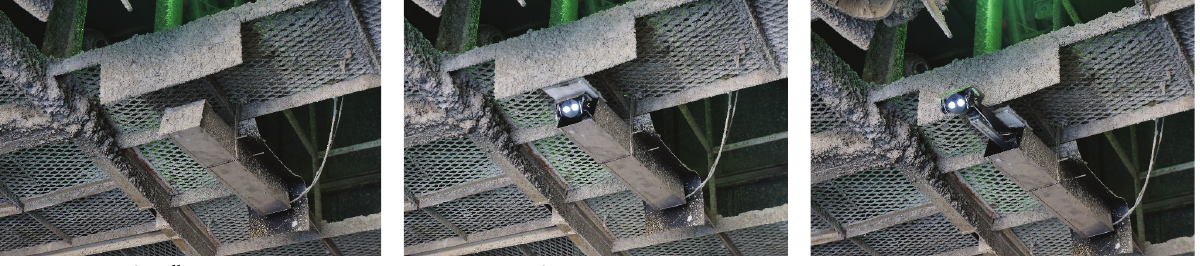
Figure 7: Operating status of the